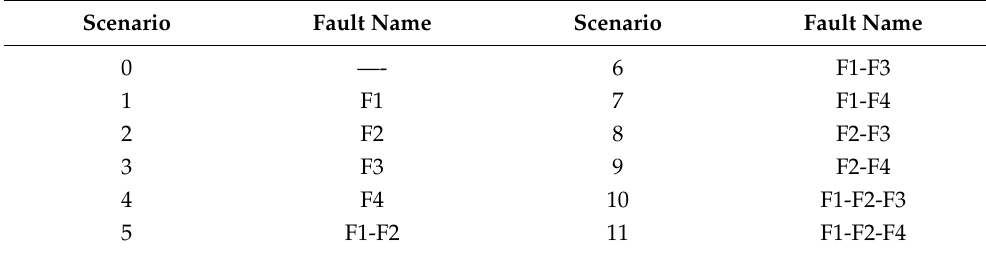
Table 8. Different scenarios for faults in satellite power system.